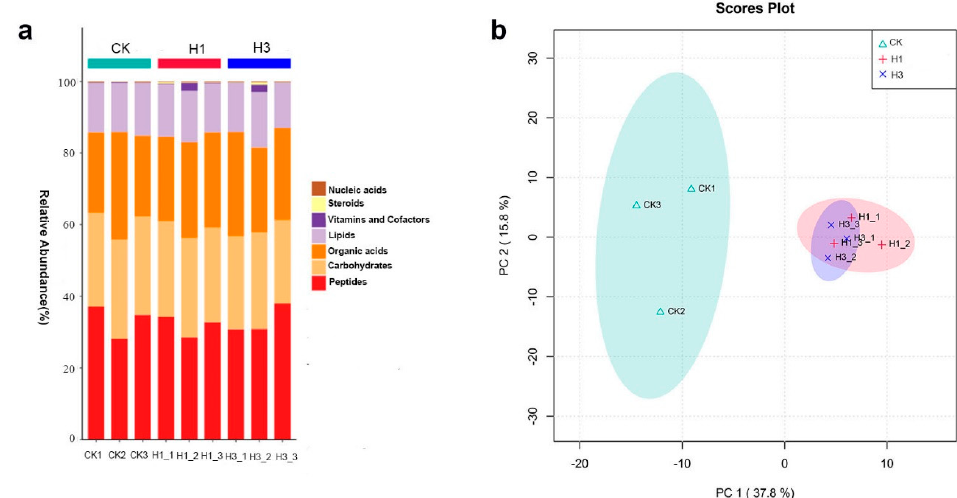
Figure 4. Statistical analysis of metabolome data. ( a ) Classification of identified metabolites, ( b ) principal component analysis (PCA) score plot. CK, control group; H1, group with heat stress treatment for 1 d; H3, group with heat stress treatment for 3 d.